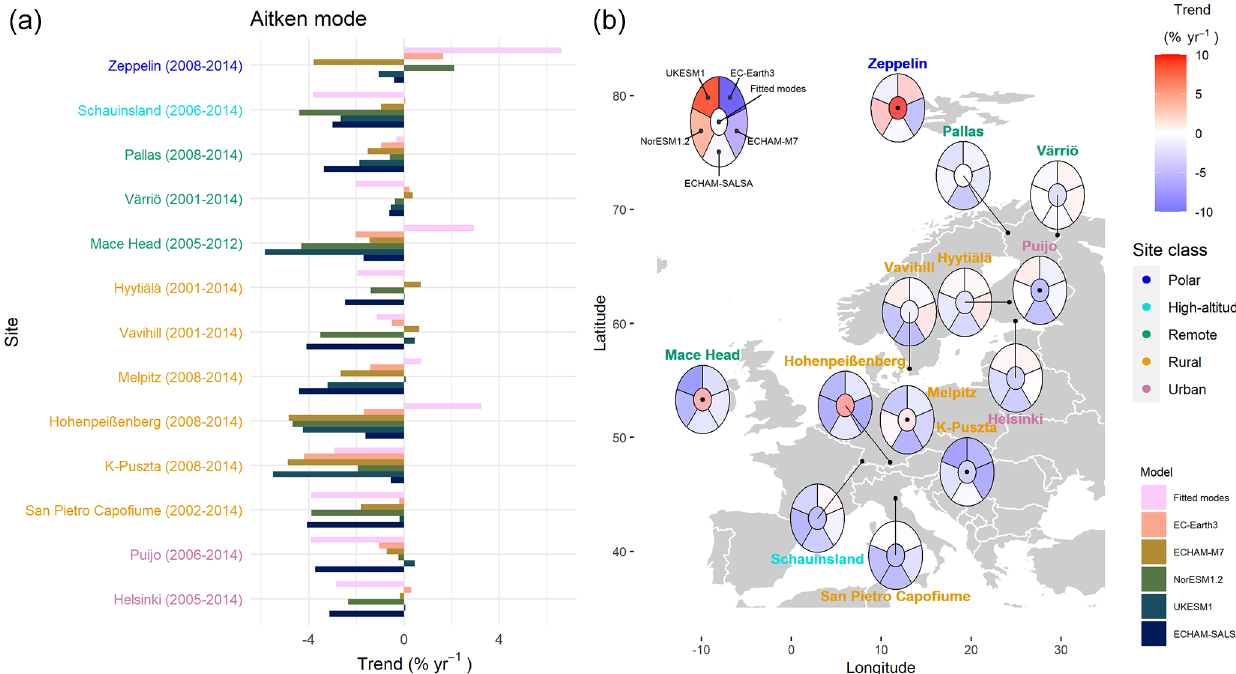
Figure 7. Long-term trend estimates for measured and modelled Aitken mode number concentration. (a) Bar plot of trends at different sites. Sites ( y axis) are arranged by site class and within site class most northerly to most southerly. (b) Estimated trends presented on the map. The colour of the central part follows the trend of the fitted modes. Trends have been calculated using the Sen–Theil estimator and complemented with bootstrap confidence intervals (see Sect.